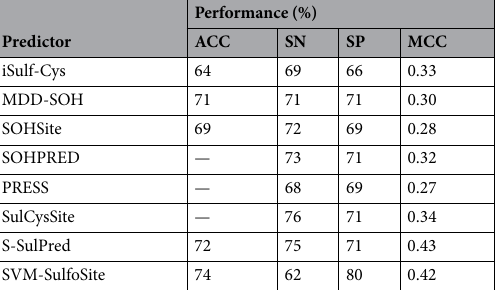
Table 4. Comparison of sulfenylation site predictors using an independent test